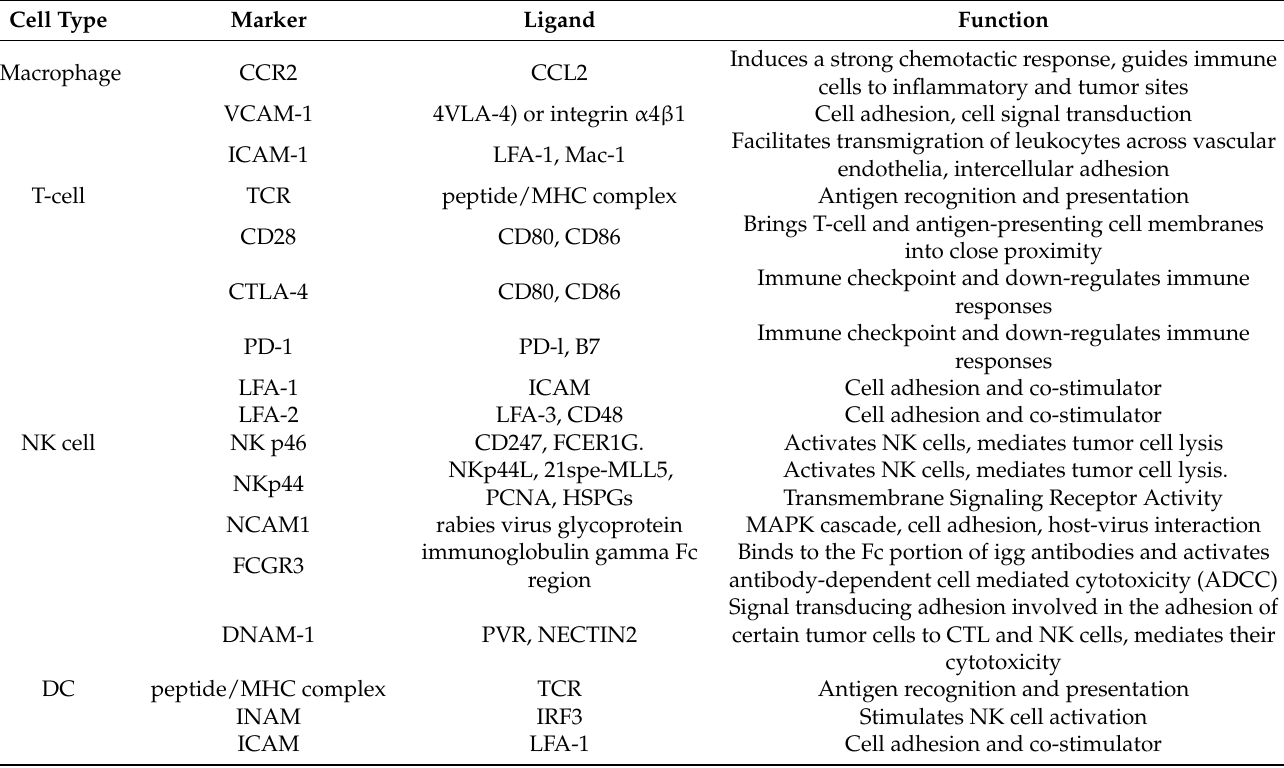
Table 1. Immunocyte Membrane Surface Markers That May Contribute to Nanomaterials’ Anti-Tumor Immune Effects. Cell